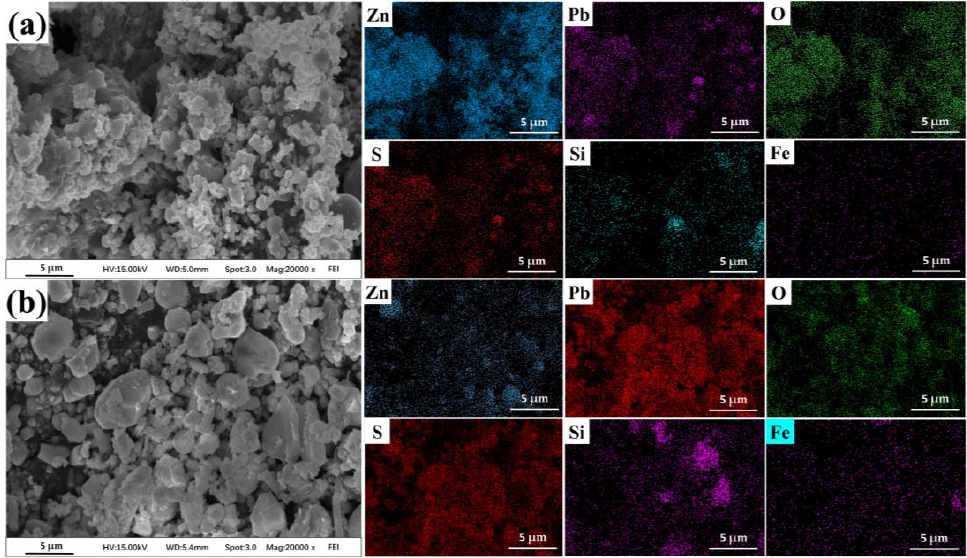
Figure 12. SEM images and EDS mapping: ( a ) the GRC sample; ( b ) the leaching residue (initial acidity = 160 g·L − 1 , leaching temperature = 90 °C, leaching time = 60 min, and L/S mass ratio = 5:1).